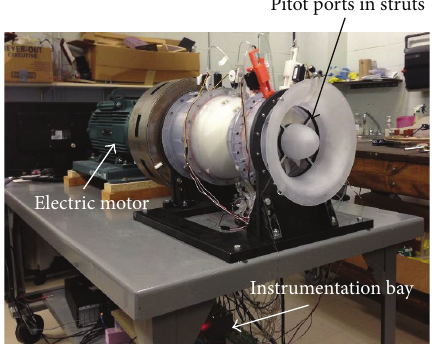
Figure 2: Low-speed axial-mixed compressor test rig with instrumentation.